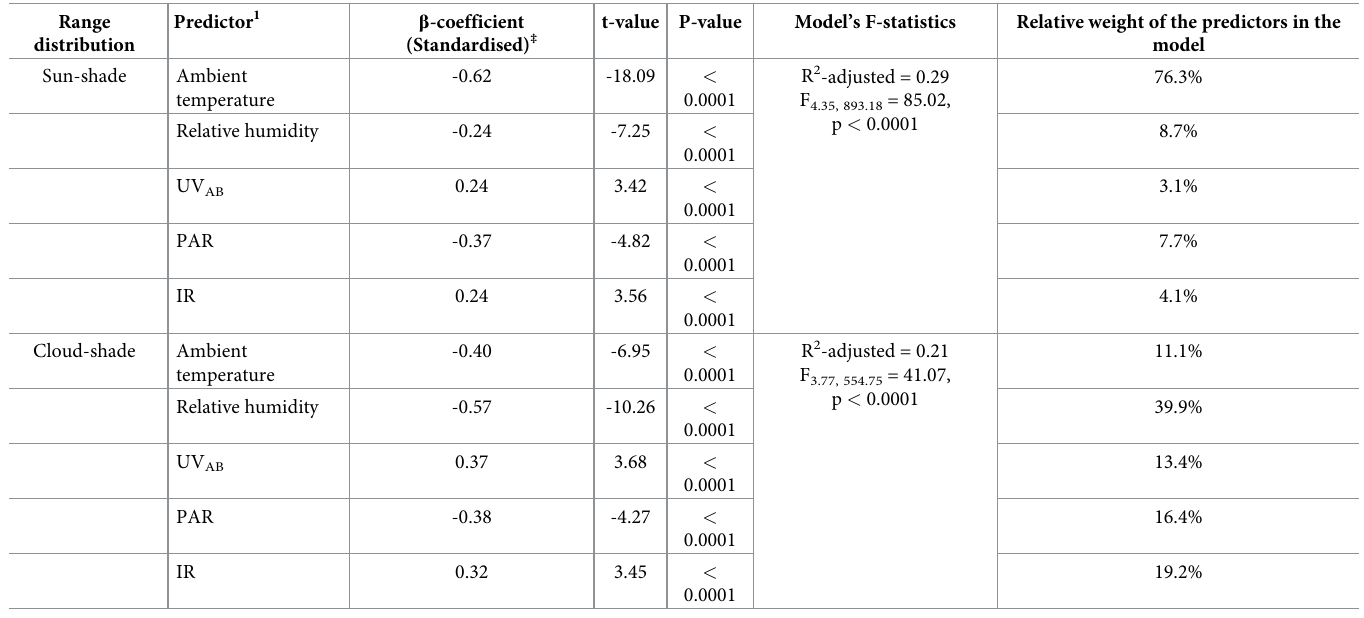
Table 6. Multiple ridge regression analyses (ridge parameter, k = 0.02) on the number of hens in the ‘sun-shade’ and ‘cloud-shade’ across the day in QLD for all observation months. Only variables that significantly contributed to the most parsimonious model are presented. Range distribution